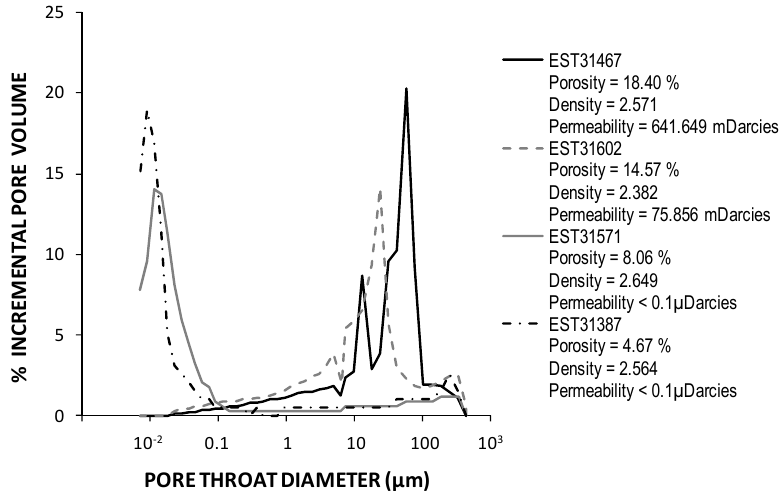
Figure 4. Pore throat distribution of Triassic sandstones samples determined by Hg analyses. The permeability values were calculated from mercury porosimetry data according to the Katz and Thompson method [47].